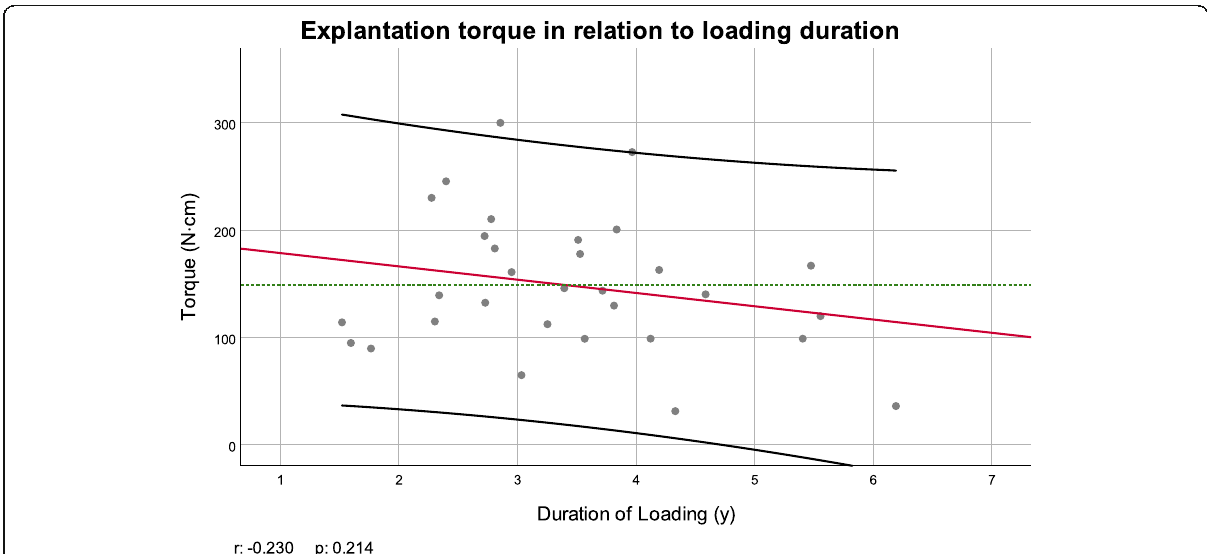
Fig. 4 Scatter plot and Pearson correlation coefficient ( r ) of torque value and duration of loading. Green dotted line: mean torque; red line: linear regression curve; black lines: 95% confidence